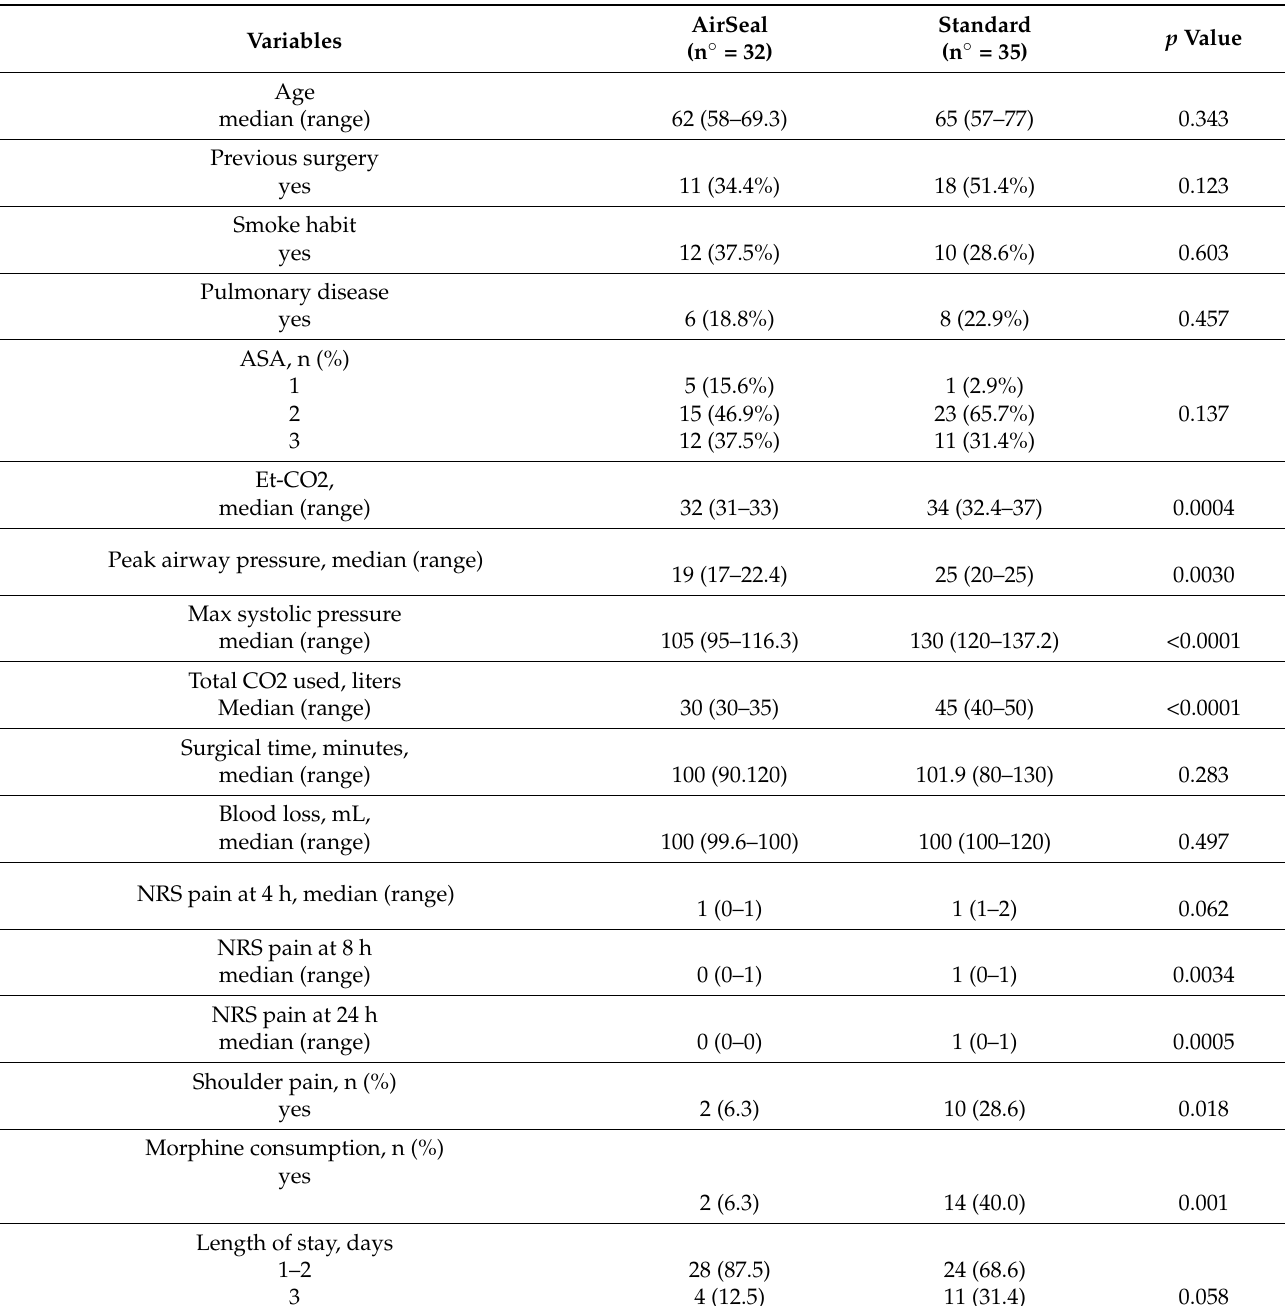
Table 3. Analysis in the subgroup of obese women with BMI greater than 30 kg/m2 (N = 77).